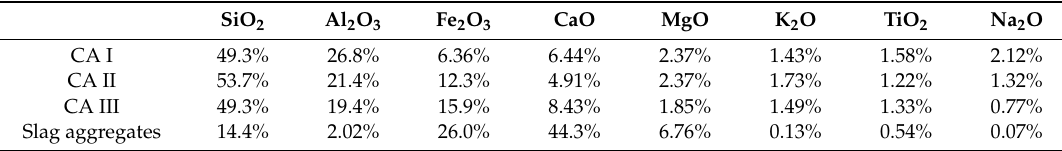
Table 5. XRF results of